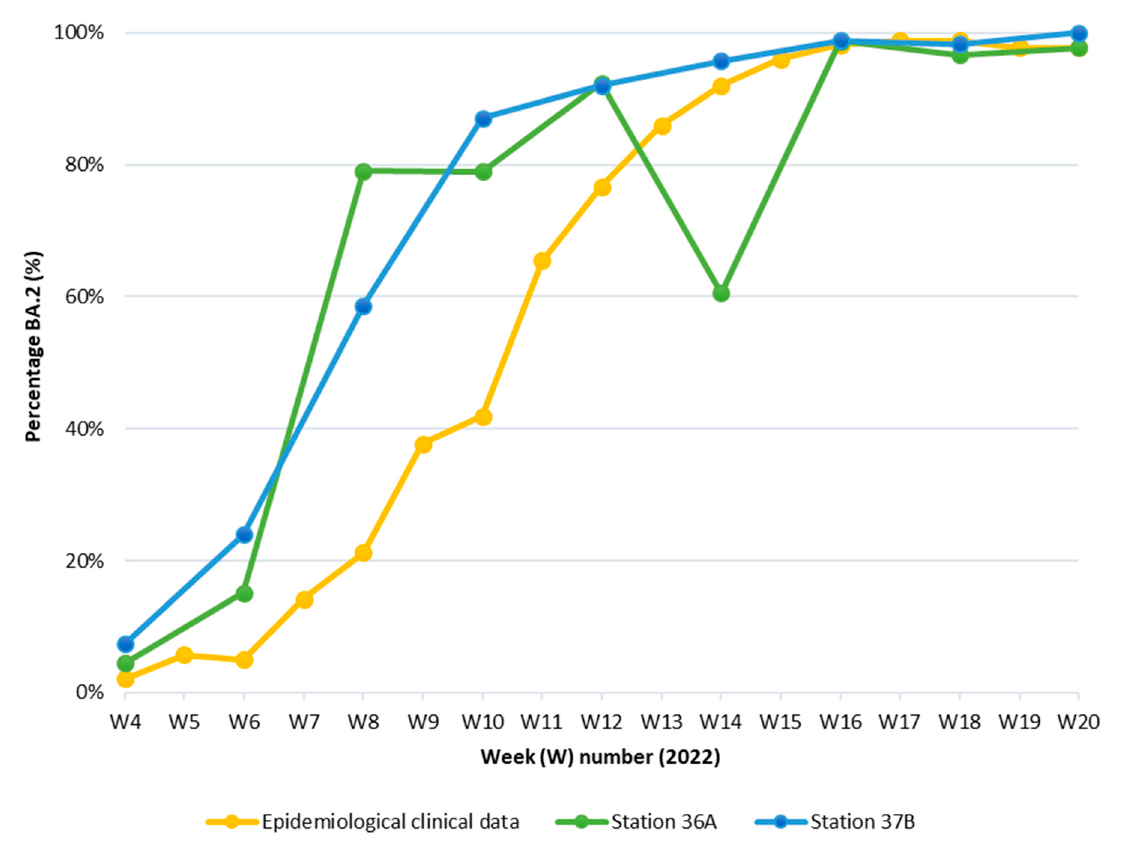
Figure 1. The concentration of mutant I19 gene divided by the total amount of virus that was found with the wild-type T19 and mutant I19 target together in two wastewater treatment plants (green and blue lines) in Brussels-Capital Region from week 4 to week 20 2022 compared to genomic surveillance data obtained by the Belgian Sequencing Consortium (yellow line). Station 36A covers a population of approximately 1,045,863 inhabitants in the north of Brussels and Station 37B covers a population of approximately 311,866 inhabitants.